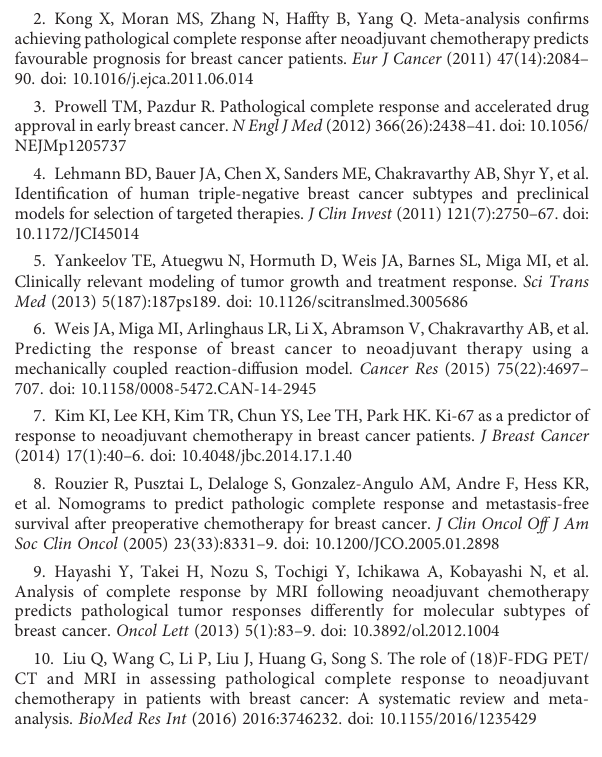
SUPPLEMENTARY FIGURE 2 Reduction in SDF-1 expression during NAC. The mean value of SDF-1 (pg/ ml) in nonpCR patients was 380.9 (95% CI: 355.2-406.6) at baseline and 392.2 (95% CI: 361.6-422.7) at surgery, whereas the mean value of SDF-1 (pg/ml) in pCR patients was 288.6 (95% CI: 253.4-323.8) at baseline and 206.4 (95% CI: 184.1-228.7) at surgery. The reduction in SDF-1 before and after NAC was correlated with pathological response, as the mean reduction was -11.3 (95% CI: -47.4-24.5) (pg/ml) in nonpCR patients and 82.2 (95% CI: 49.7-114.8) (pg/ml) in pCR patients (P=0.004). In subgroup analyses, a signi fi cant difference in SDF-1 reduction between pCRandnonpCRresponders wasonlyobservedinpatients